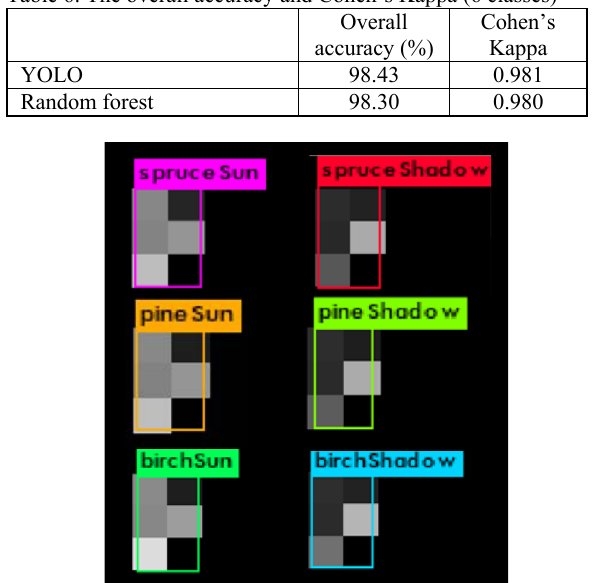
Table 6. The overall accuracy and Cohen’s Kappa (6 classes)